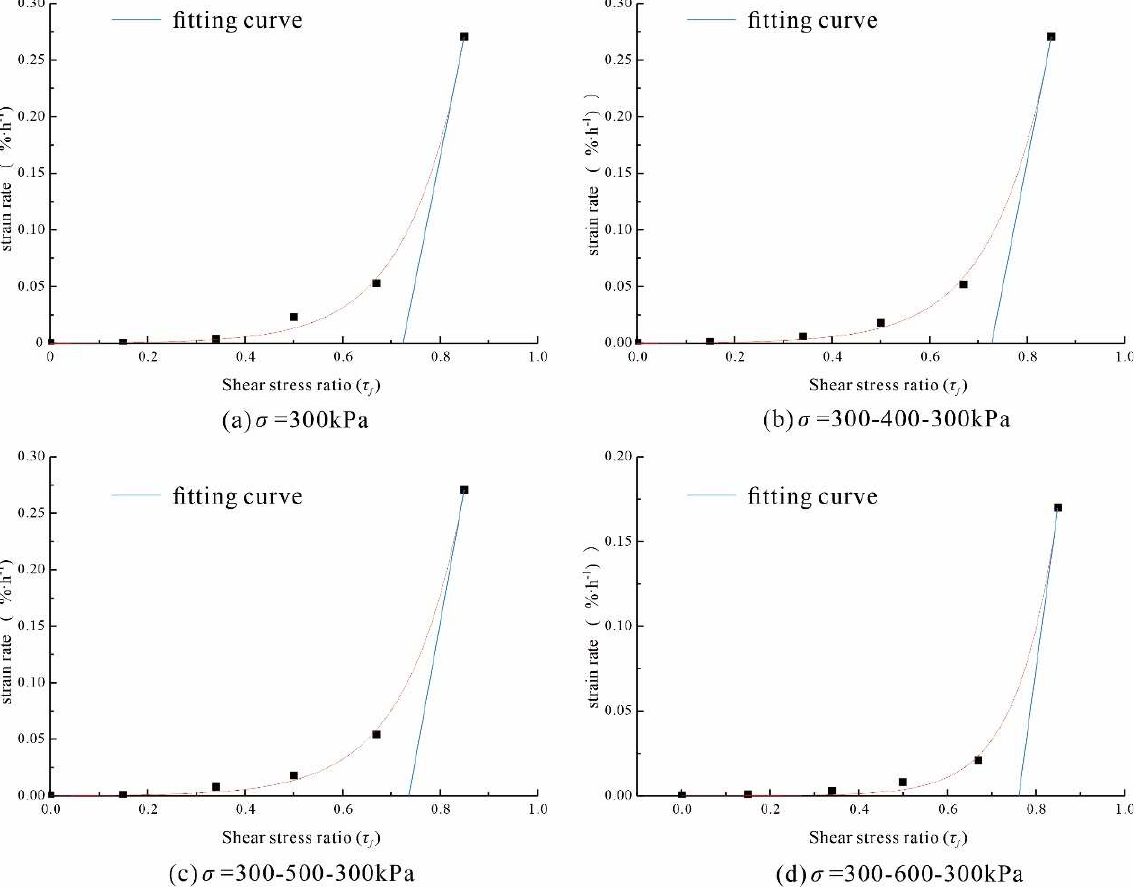
Figure 18. The steady-state creep rate versus shear stress curve.